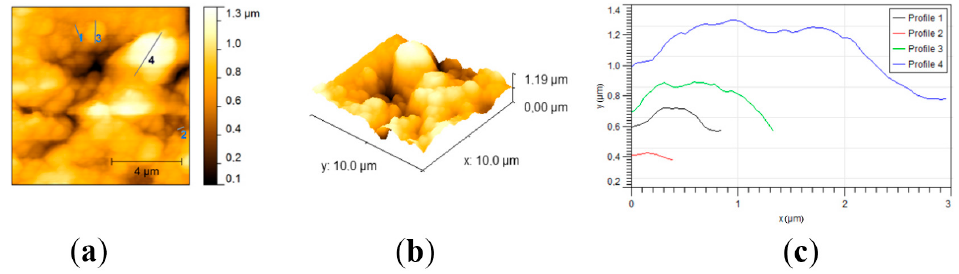
Figure 7. AFM micrographs and statistical data of the MTA surface. ( a ) Top view; ( b ) 3D view; Figure 7 . AFM micrographs and statistical data of the MTA surface . (a) Top view; (b) 3D view; (c) ( c ) crystals crystals profiles.